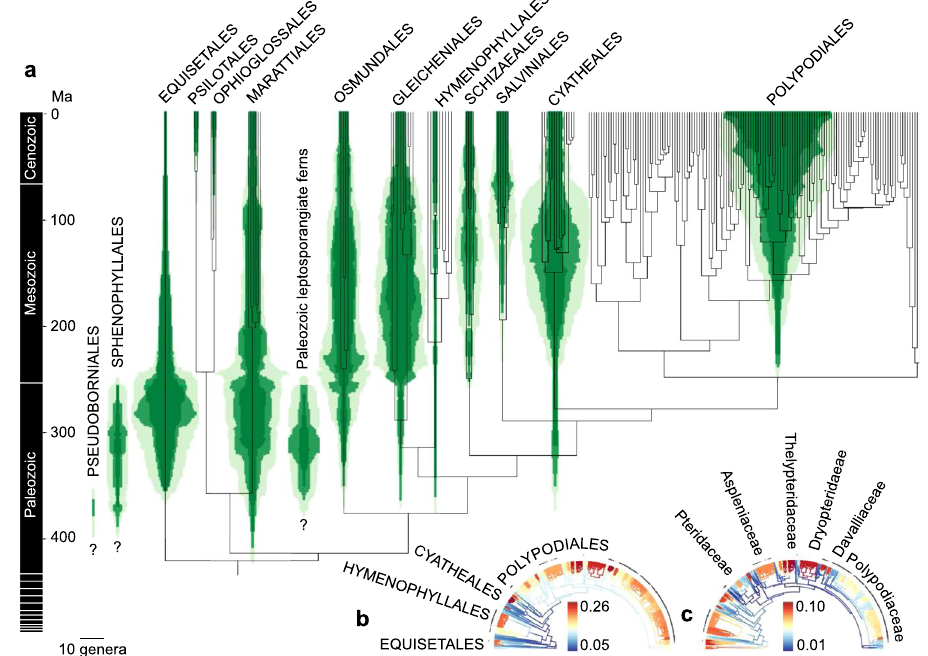
Figure 2. Diversification dynamics of ferns through time. ( a ) The green diagrams show the diversity dynamics of fern genera that were assigned to higher taxa (orders) inferred from the fossil record (Supplementary Table 1), plotted above a time-calibrated molecular phylogeny collapsed to the genus level. Pale green indicates the estimated maximum diversity (95% HPD), dark green the estimated minimum (95% HPD), and intermediate green the estimated mean diversity. ( b ) Diversification rate shifts identified from a species-level phylogeny for speciation and ( c ) extinction rates. Some important higher taxa (orders in b and families in c ) are labelled and epiphytic species indicated by